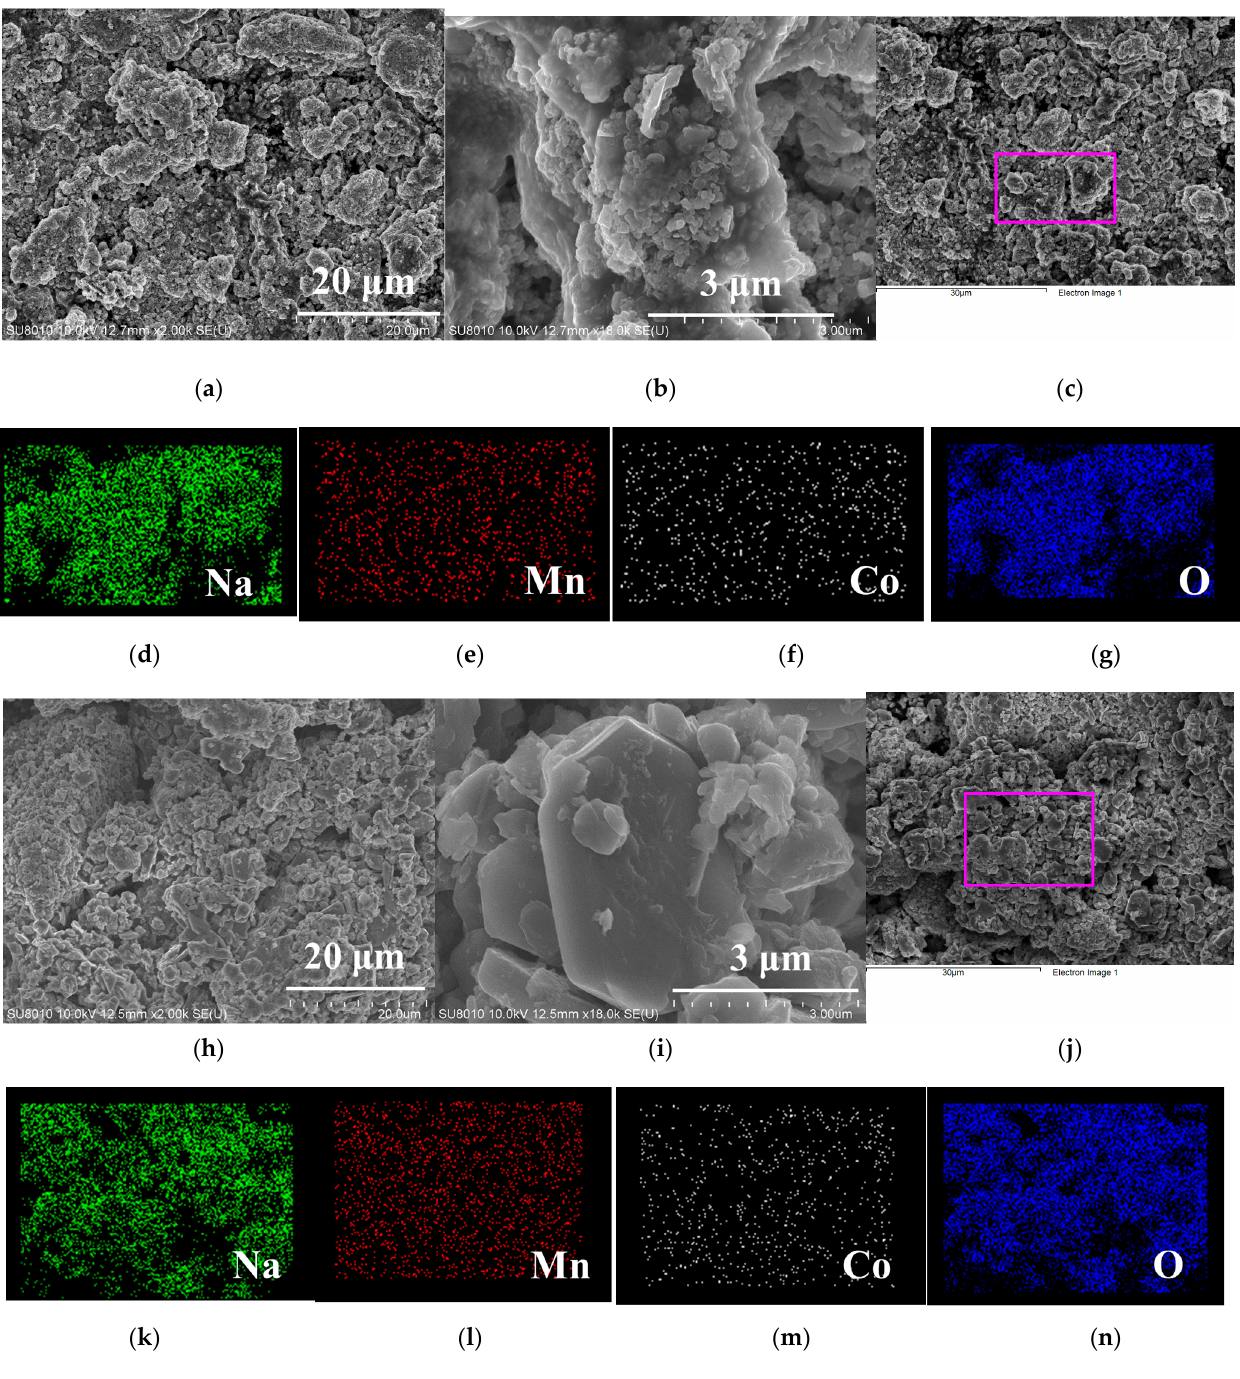
Figure 3. ( a – c ) SEM images of NMC material calcined at 650 °C and ( d – g ) EDX mapping results of area in the SEM image ( c ); ( h – j ) SEM images of NMC material calcined at 800 °C and ( k – n ) EDX mapping results of area in the SEM image ( j ).